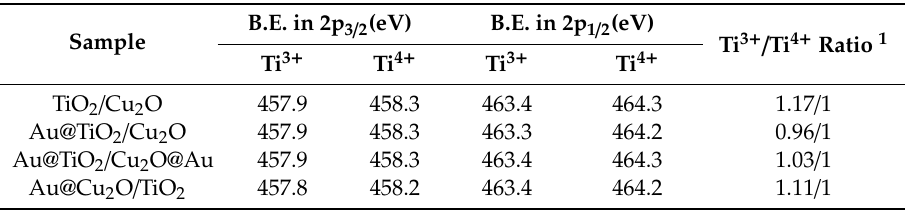
Table 1. Ti 2p XPS analyses of the